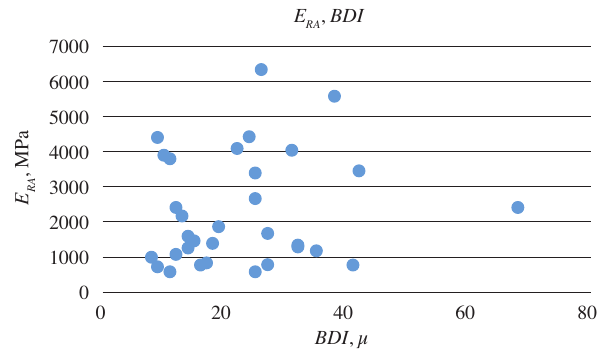
Figure 3. Relationship between modulus of elasticity of RA and BDI